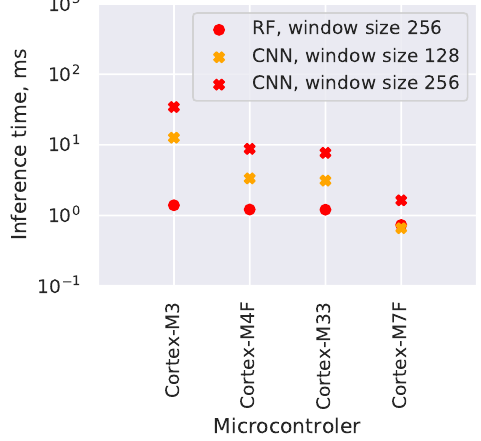
Figure 8. The custom CNN and RF inference speed comparison on different microcontrollers. Cortex- M3 was not able to run the CNN with window size 256 due to its limited RAM. RF with feature window size 128 not shown, as its speed closely matches the RF with window size